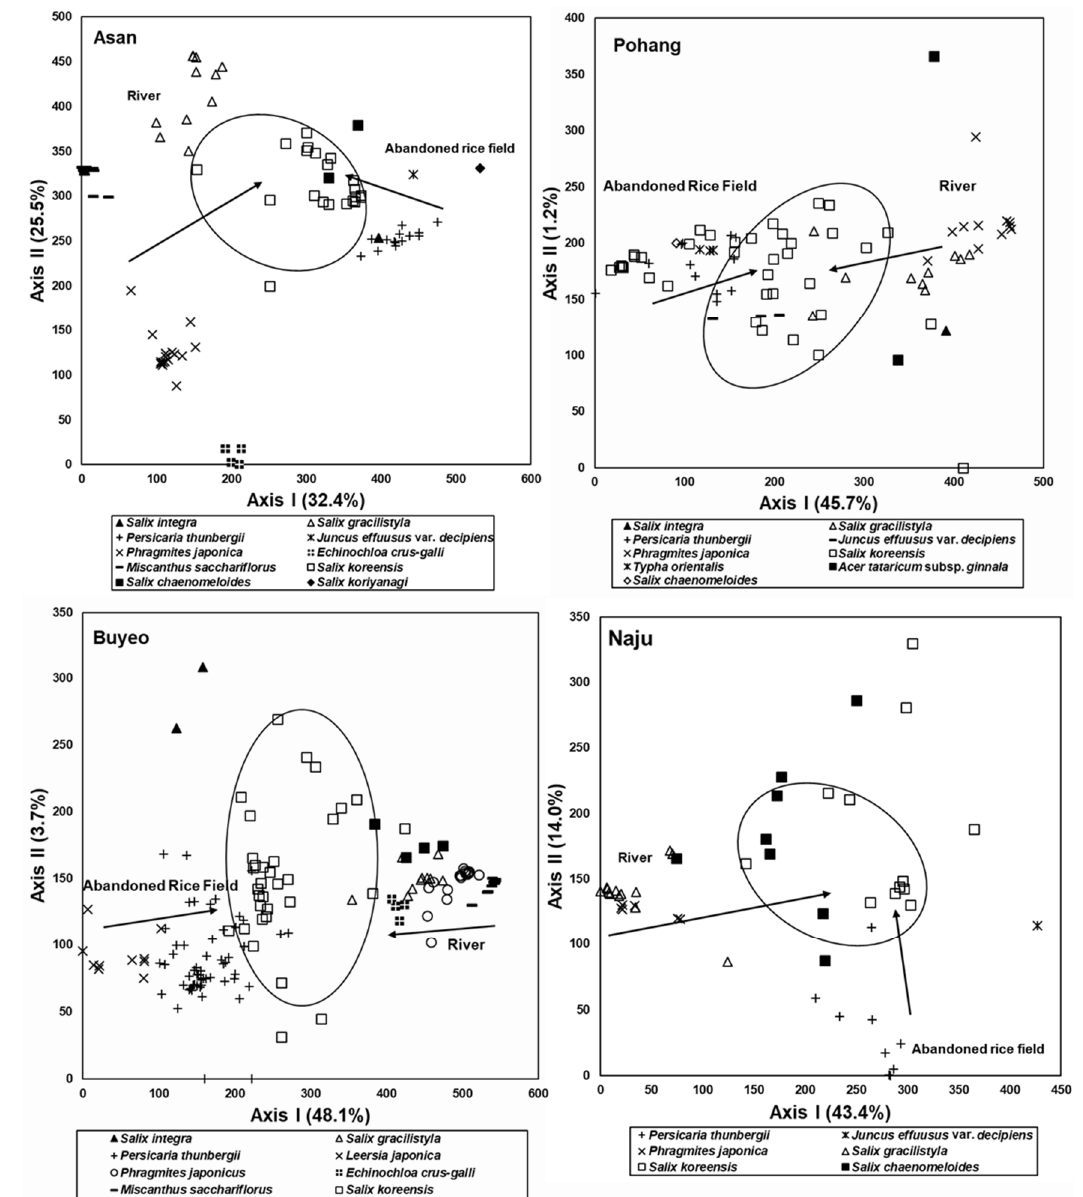
Figure 7. DCA ordination of stands based on vegetation data obtained from both abandoned rice fields and riparian zones of four rivers in watersheds where the rice fields are located. Arrangement of stands reflected successional change over years after abandonment and the sequence resembled the spatial distribution pattern of riparian vegetation appearing to recede from the waterfront in the riparian zone. ‘Abandoned Rice Field’ indicates stands surveyed in the rice fields and ‘River’ indicates stands surveyed in the riparian zones. The arrows show the successional trend in the abandoned rice fields and the changing trend of riparian vegetation according to the distance from the waterway. The stands in the part divided by solid lines represent the riparian forest stands established in the late successional stages of the abandoned rice fields and established at the farthest distance from the waterway in the riparian vegetation. They usually consist of a S. koreensis community, but they are mixed with Salix chaenomeloids community, Acer tataricum subsp. ginnala community, Fraxinus rhynchophylla community, and A. japonica community depending on the region.